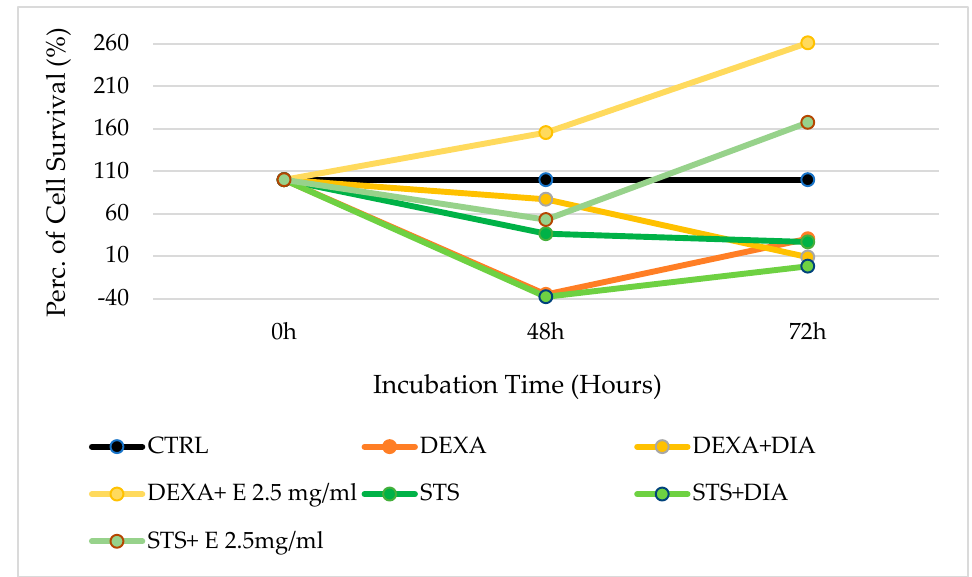
Figure 5. Percentage of cell growth values of bone marrow cells co-incubated with dexamethasone (DEXA) and staurosporine (STS), in the presence of diazoxide (DIA), and the extract (E) with a concentration of 2.5 mg/mL measured using the crystal violet assay, compared to control (CTRL). Data are shown for a 2.5 mg/mL concentration of the extract after 48 h and 72 h of incubation. One- way ANOVA testing for differences between and within groups of treatments showed significant differences between treatments (F > 1.9 and p < 0.005) for DEXA and DEXA 2.5 E , STS and STS + E 2.5 after 48 and 72 h (N experiments = 6). The negative values in the figure were due to the calculation made relative to the percentage values of the number of cells in each well which in turn were derived through the calibration curve obtained from a growth curve in the 96-well plates. Thus, when a negative number for the percentage of cell survival is obtained, this means that there is a very low absolute value.